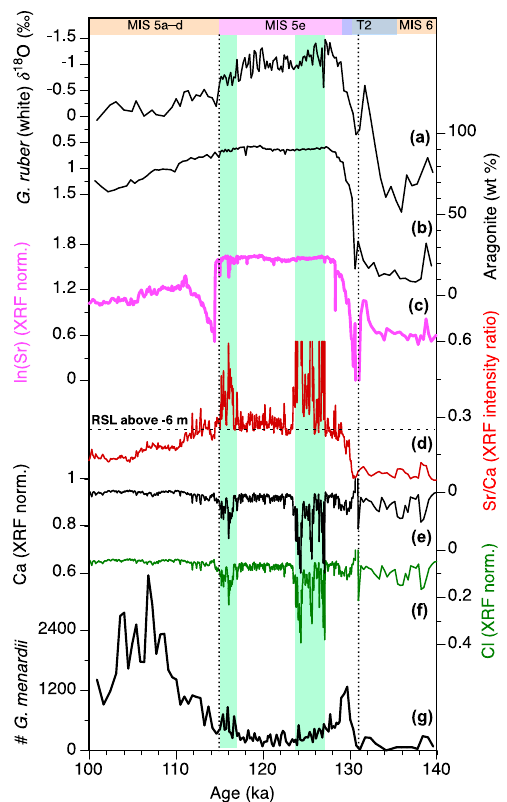
Figure 3. XRF-scan results, sedimentological and foraminiferal data from core MD99-2202 for the 140–100ka period. (a) δ 18 O values in G. ruber (white) and (b) aragonite content; (a–b) is from Lantzsch et al. (2007). Normalized elemental intensities of (c) Sr, (e) Ca and (f) Cl, (d) Sr / Ca intensity ratio (truncated at 0.6) and (g) absolute abundances of G. menardii per sample. Green bars denote core intervals with biased elemental intensities due to high seawater content. The inferred platform flooding interval (see text) is consis- tent with the enhanced production of Sr-rich aragonite needles and a RSL above − 6m (d) . T2 refers to the position of the penultimate deglaciation (Termination 2). Dashed vertical lines frame MIS 5e. Figure 4. Proxy records from core MD99-2202 over the last inter-